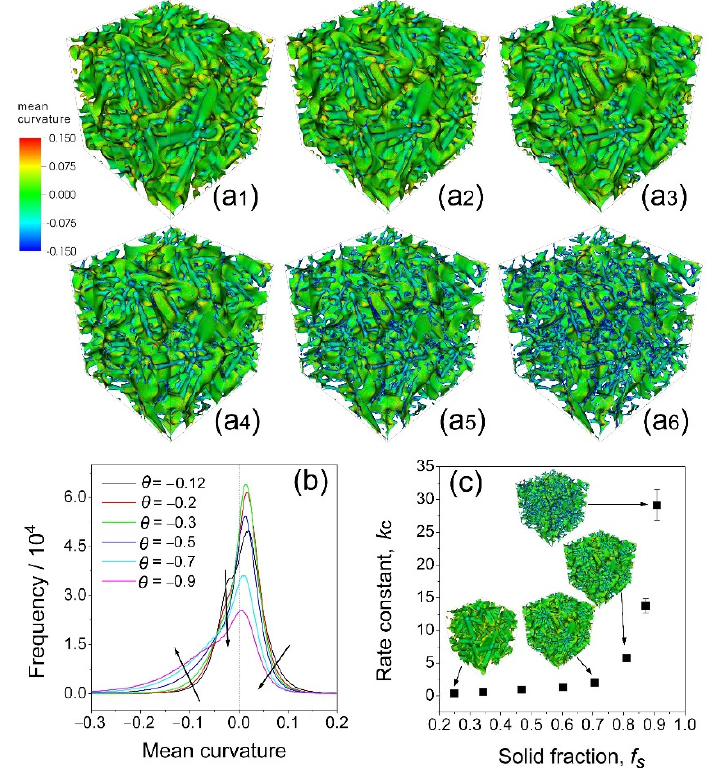
Figure 9. ( a 1 – a 6 , b ) The snapshots and the distribution of mean curvature changes of the simulated domain at different isothermal temperatures at 8 × 10 4 dt , respectively. ( a 1 – a 6 ) Snapshots of simulated domain at θ = − 0.12, − 0.20, − 0.30, − 0.50, − 0.70, and − 0.90. ( c ) The comparison between simulation and fitted results for different simulation cases.